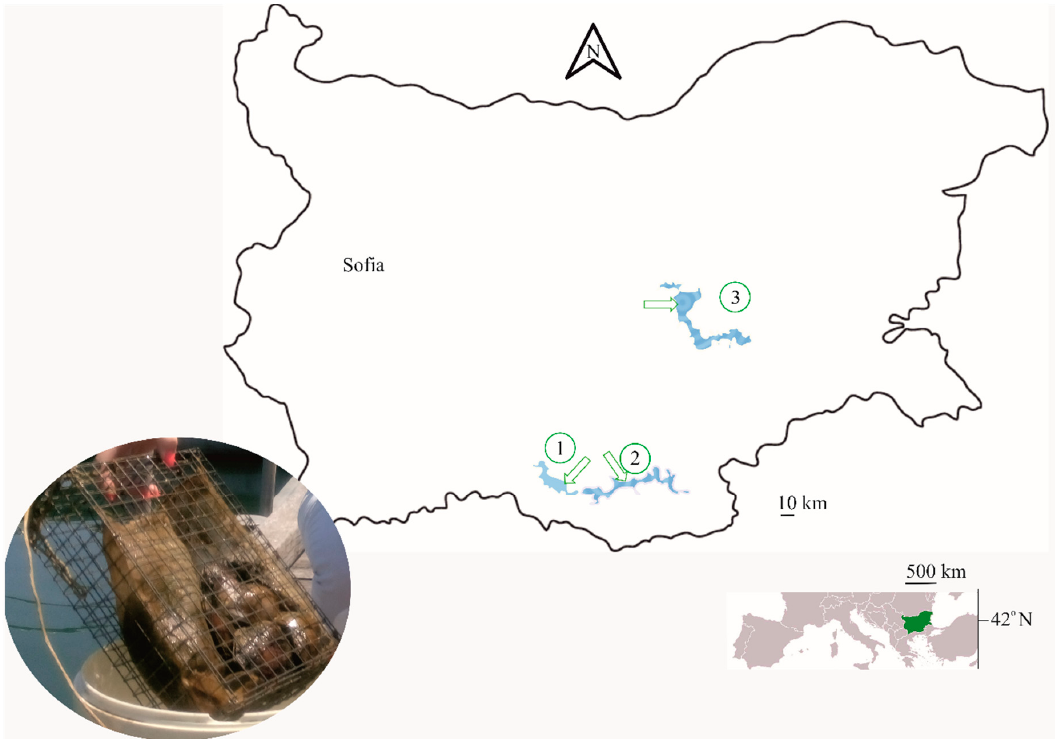
Figure 1. Studied standing water bodies: 1-Kardzhali; 2-Studen Kladenets; 3-Zhrebchevo Reservoir and location of the sampling sites (arrows).